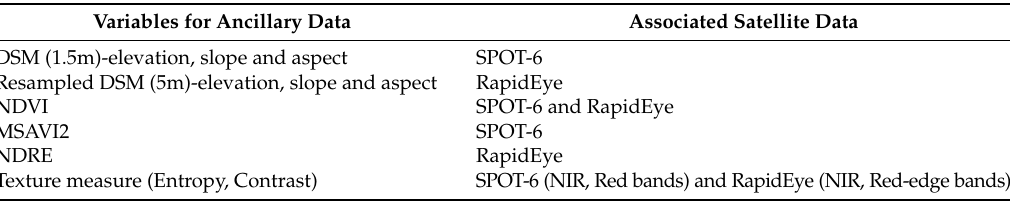
Table 2. Global list of variables used as ancillary